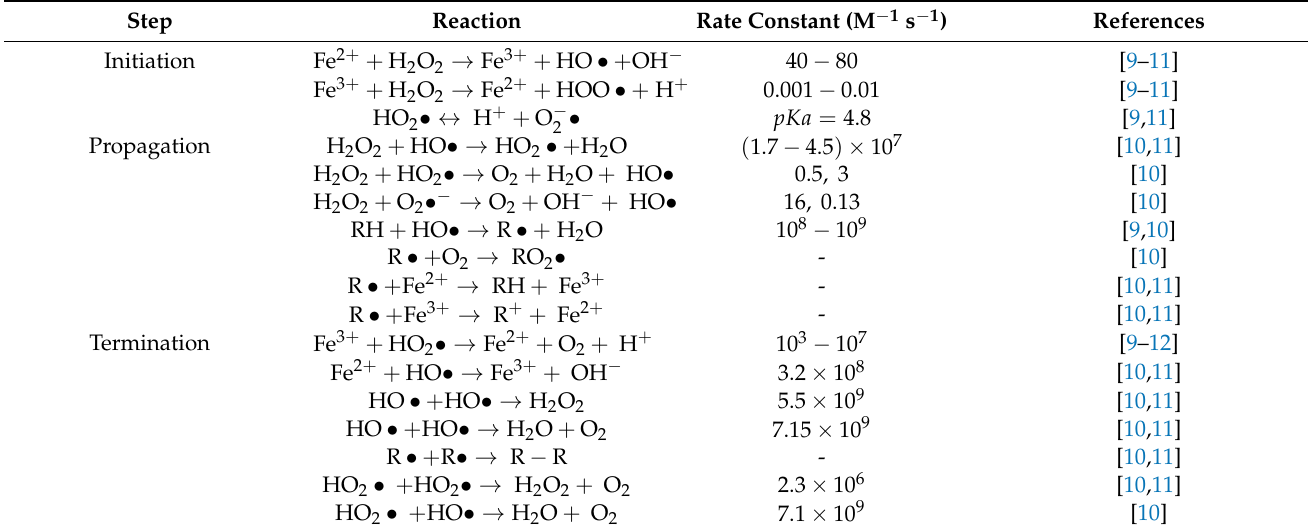
Table 1. Possible reaction steps in the Fenton